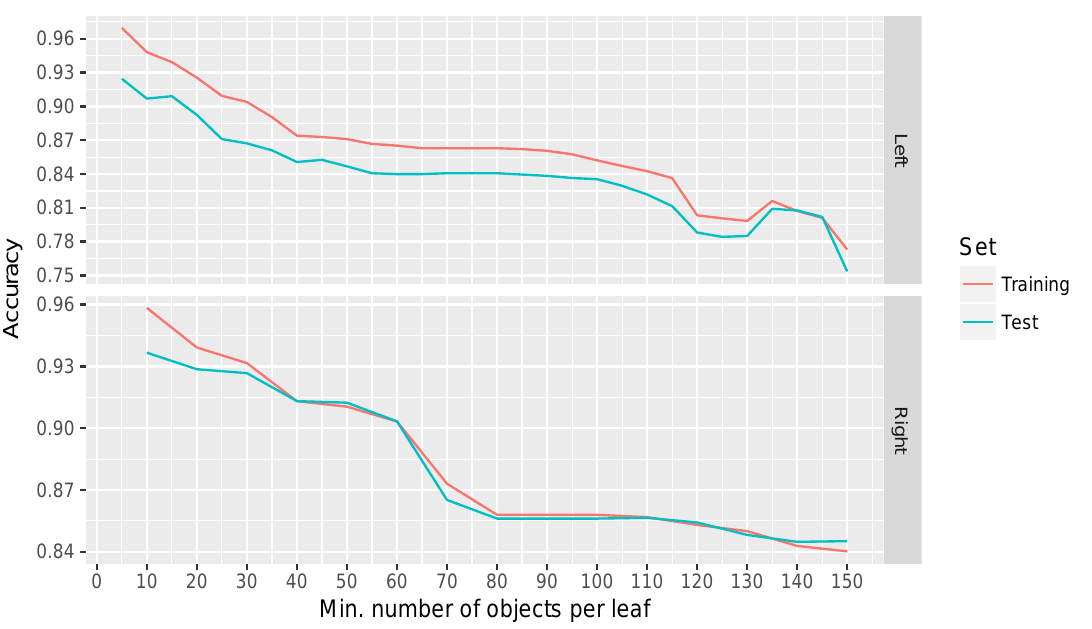
Figure 12. Results in terms of accuracy in the experiments performed using a decision tree classifier for both limbs.